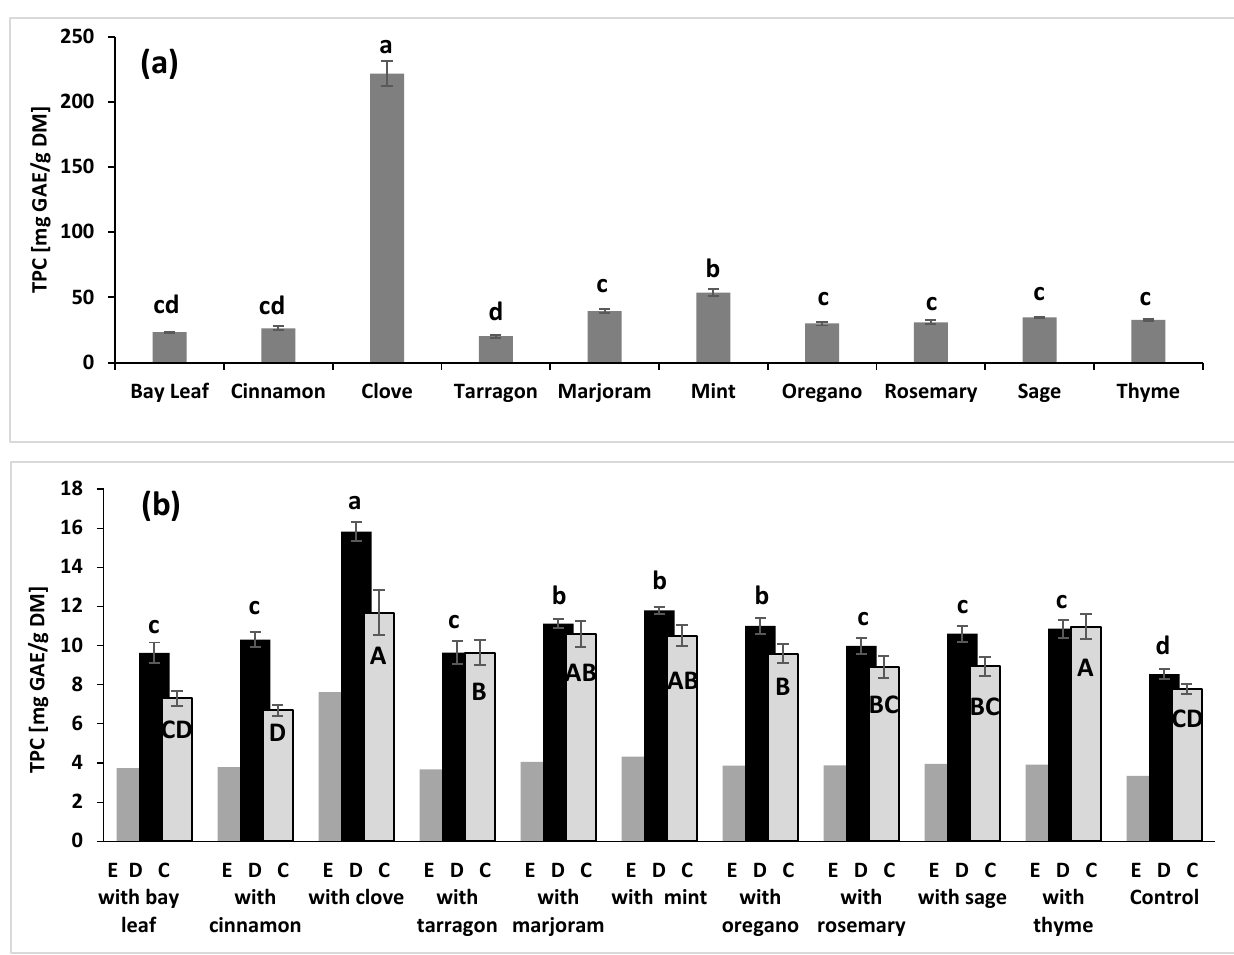
Figure 1. The total phenolic content (TPC) in ( a ) spices/herbs samples and ( b ) doughs—D; cookies—C prepared with spices/herbs, and empiric TPC calculated from its amount in individual components—E. Results are expressed as mean ± standard deviation. Values with different letters (a–d; A–D) are significantly different ( p < 0.05).